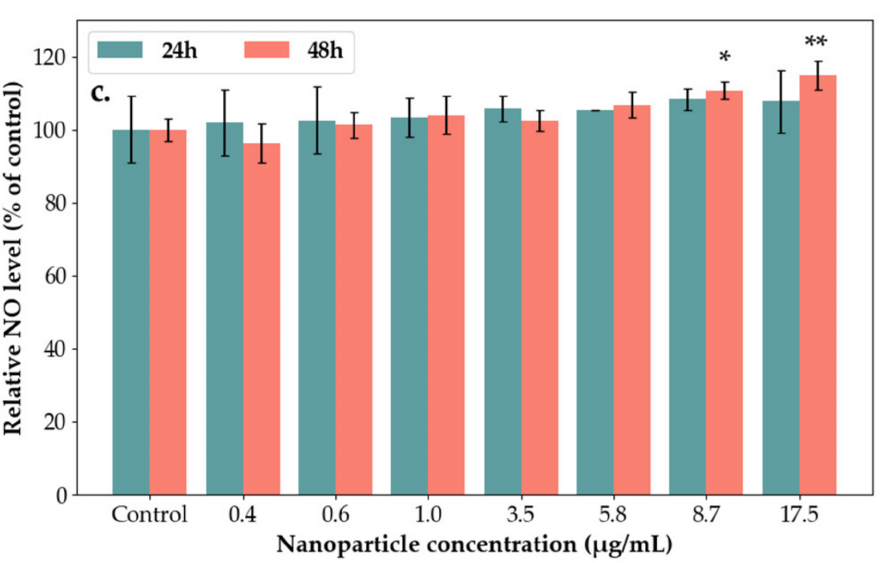
Figure 12. Biological tests performed on SAg/AuNPs-WT using the following techniques: ( a ) MTT assay after 24 h and 48 h of exposure to different concentrations of SAgNPs-WT in keratinocytes. Via- bility percentage was normalized to the untreated cells (without SAgNPs-WT). Results are calculated as mean ± SD (n = 3) and expressed as a percentage (%) of the control. ( b ) The lactate dehydrogenase released after 24 h and 48 h of exposure to different concentrations of SAgNPs-WT in HaCaT cells. Results are calculated as mean ± SD (n = 3) and expressed as a percentage (%) of control. ( c ) Effects of SAgNPs-WT on production of nitric oxide (NO) in HaCaT cells. Cells were treated with SAgNPs-WT (0.4–17.5 µ g/mL) for 24 h and 48 h. Results are calculated as mean ± SD (n = 3) and expressed as a percentage (%) of the control. ** p < 0.01, * p <